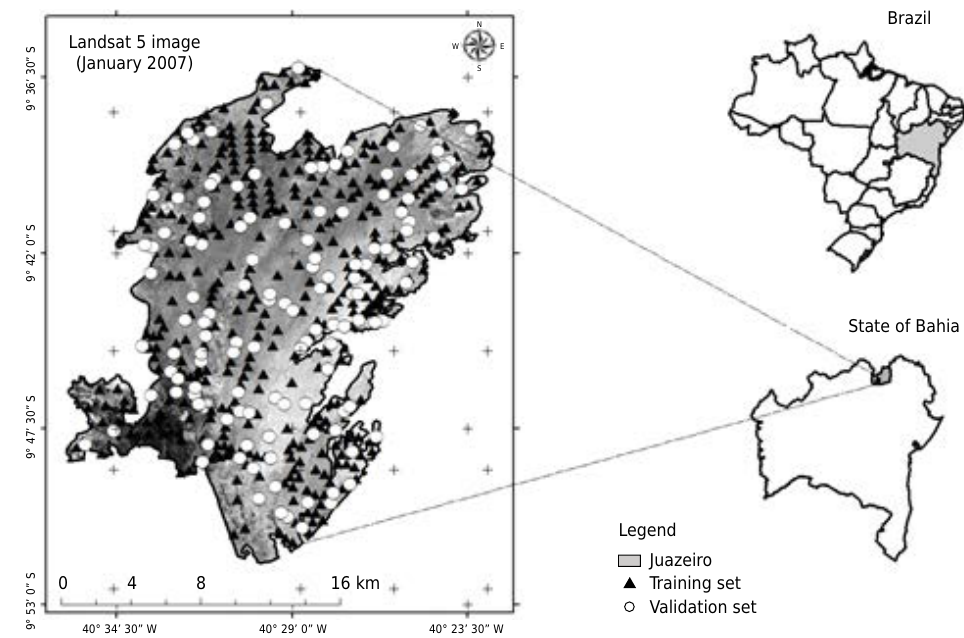
Figure 1. Study area and location of soil profiles, over Landsat image